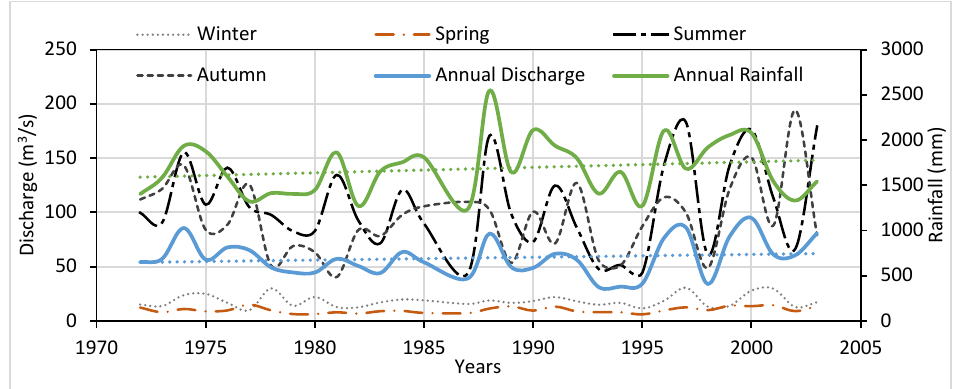
Figure 6. Seasonal and annual average discharge at Mainachuli Station, Kankai River Basin, along with the annual rainfall at station 1407.